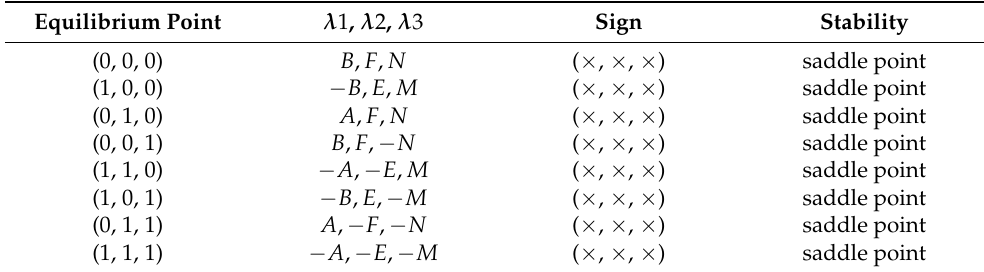
Table 3. Strategy portfolio stability